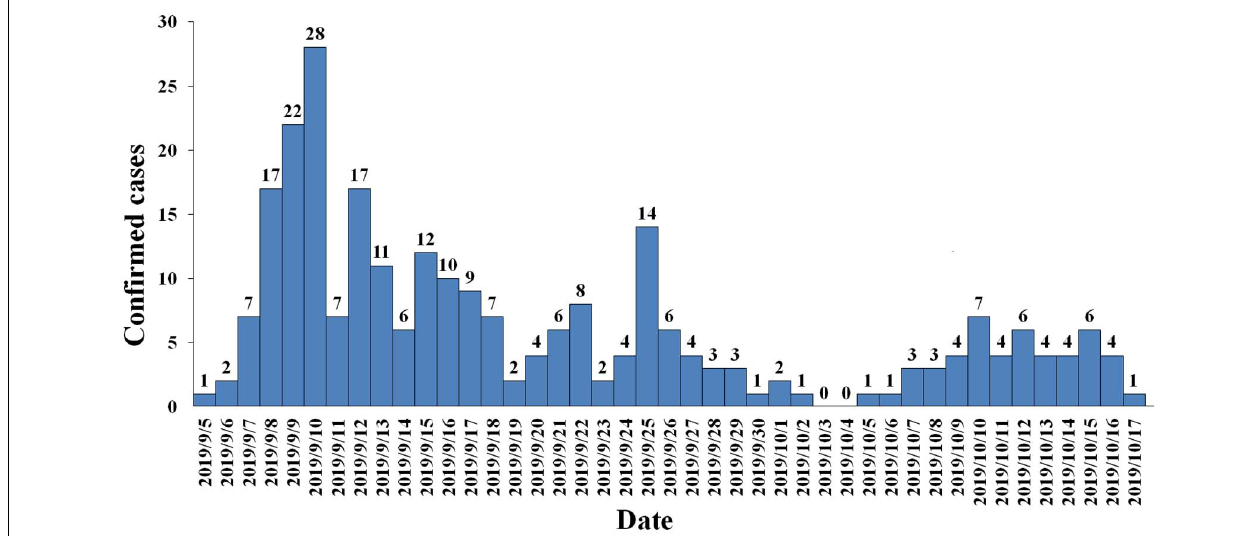
FIGURE 1 | Daily trend chart of confirmed dengue fever cases.